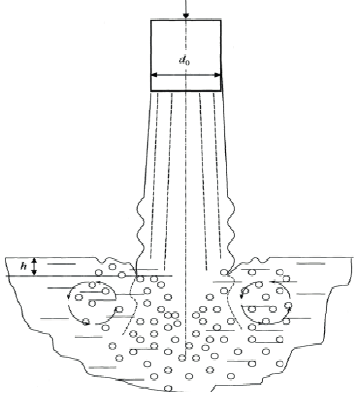
Fig. 2. Scheme of gas-liquid mixture